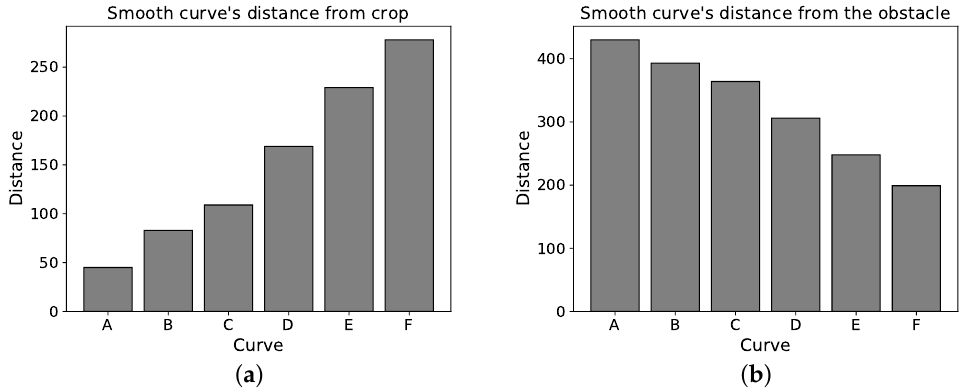
Figure 9. Safety distance of robot from the crop and the obstacle in case of simulation in Figure 8a. ( a ) Distances of different trajectories from the crop. ( b ) Distances of different trajectories from the